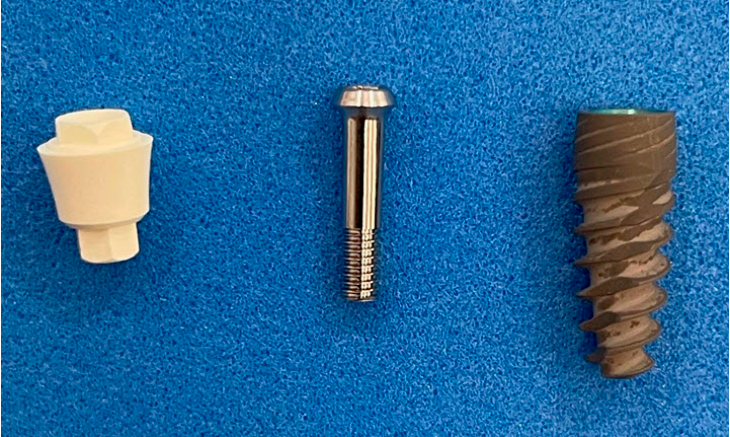
Figure 1. Zirconia–ceria/alumina composite abutment (left), Ti 6Al-4V ELI screw (center) and JD EVOLUTION PLUS+ commercial titanium implant (right).